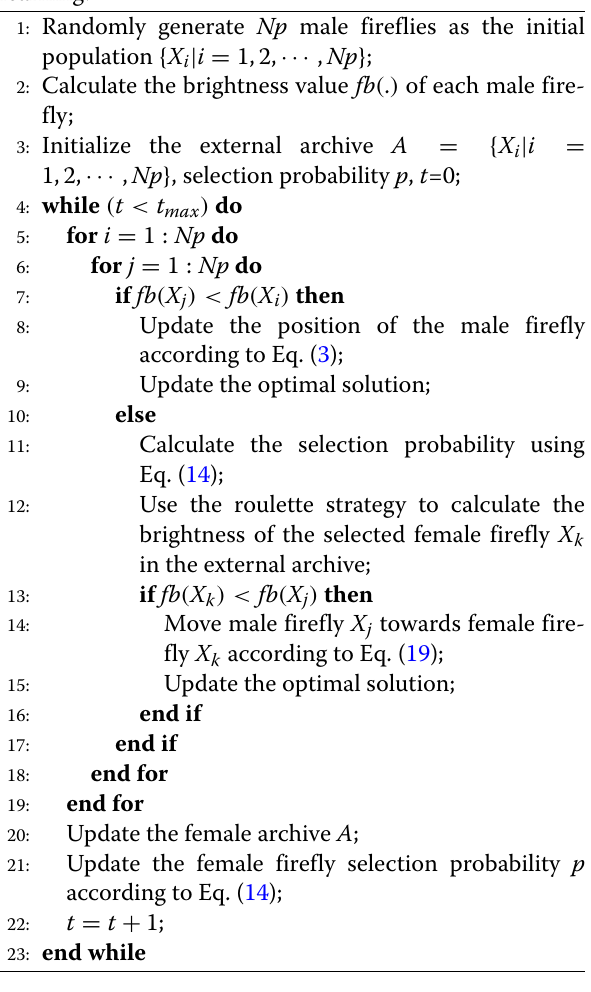
Algorithm 1 Improved firefly algorithm with courtship learning.